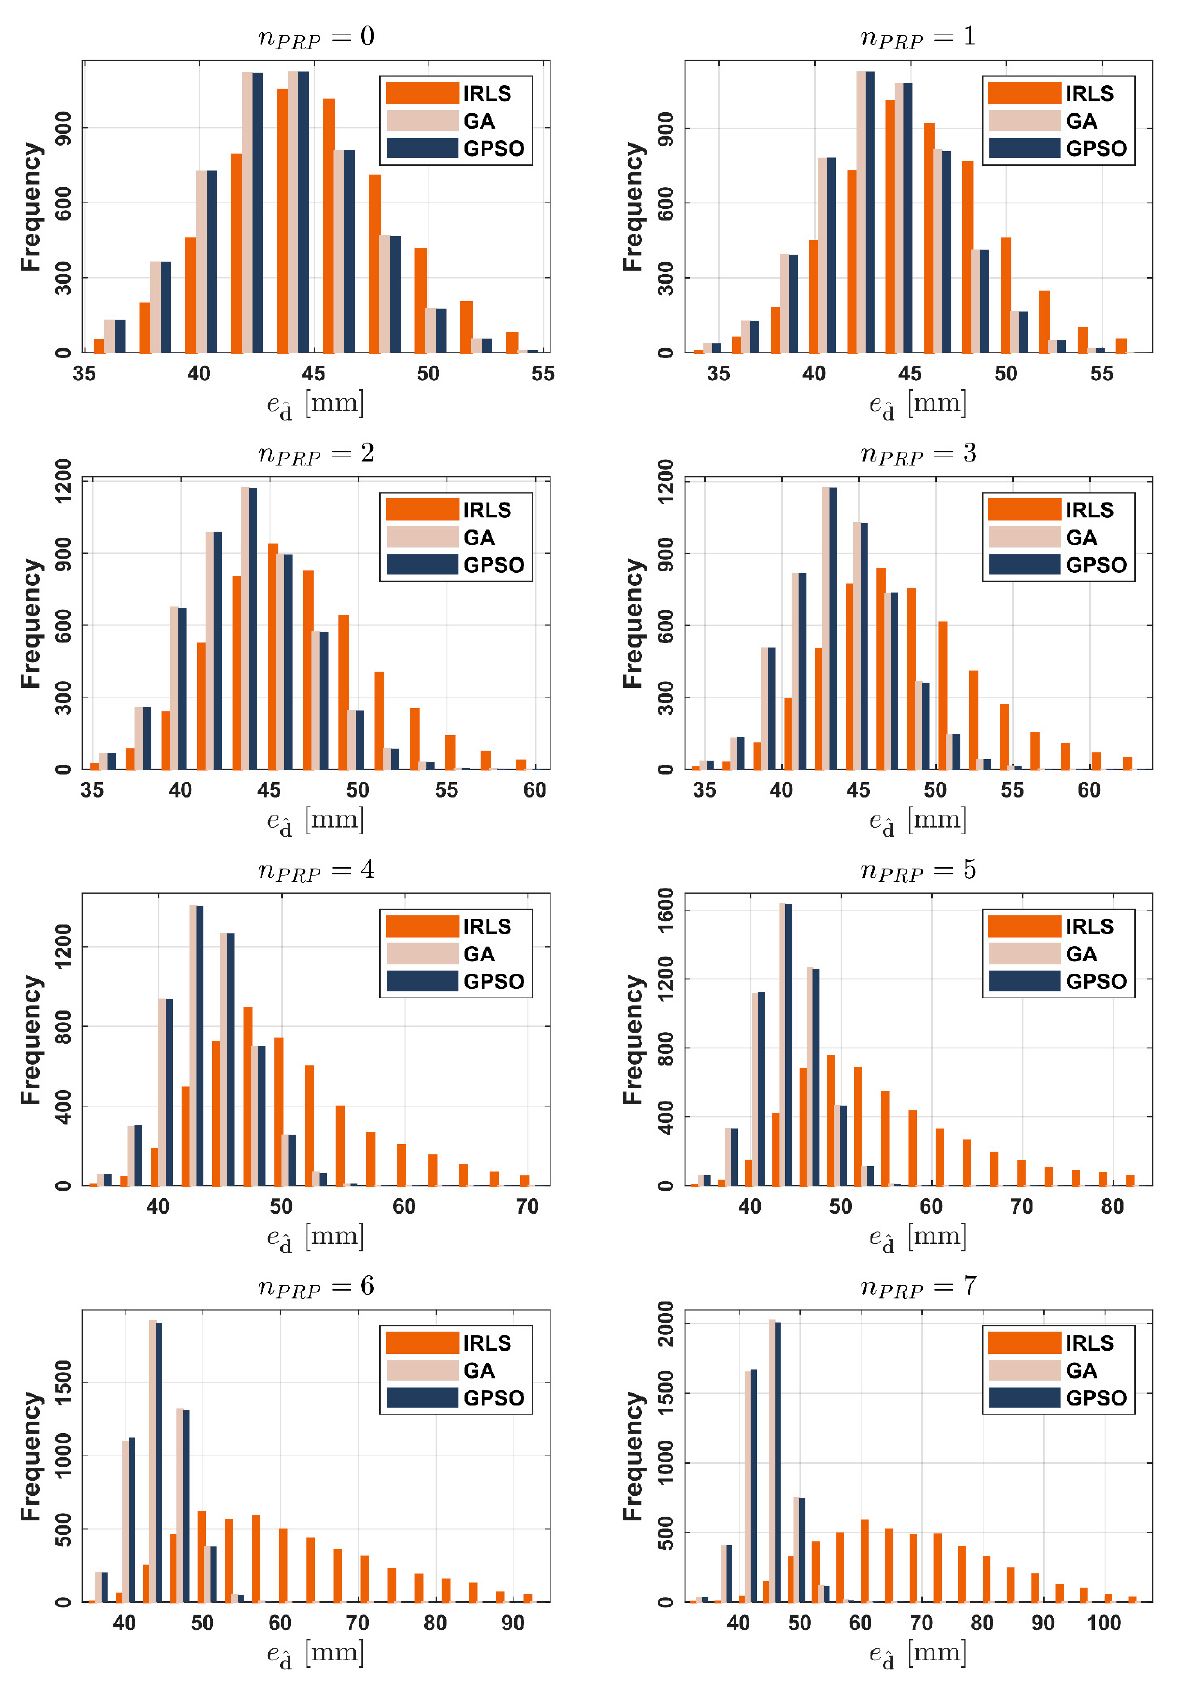
Figure A2. Empirical distributions of overall absolute true errors 𝑒 𝐝 (cid:4632) for variant 2.